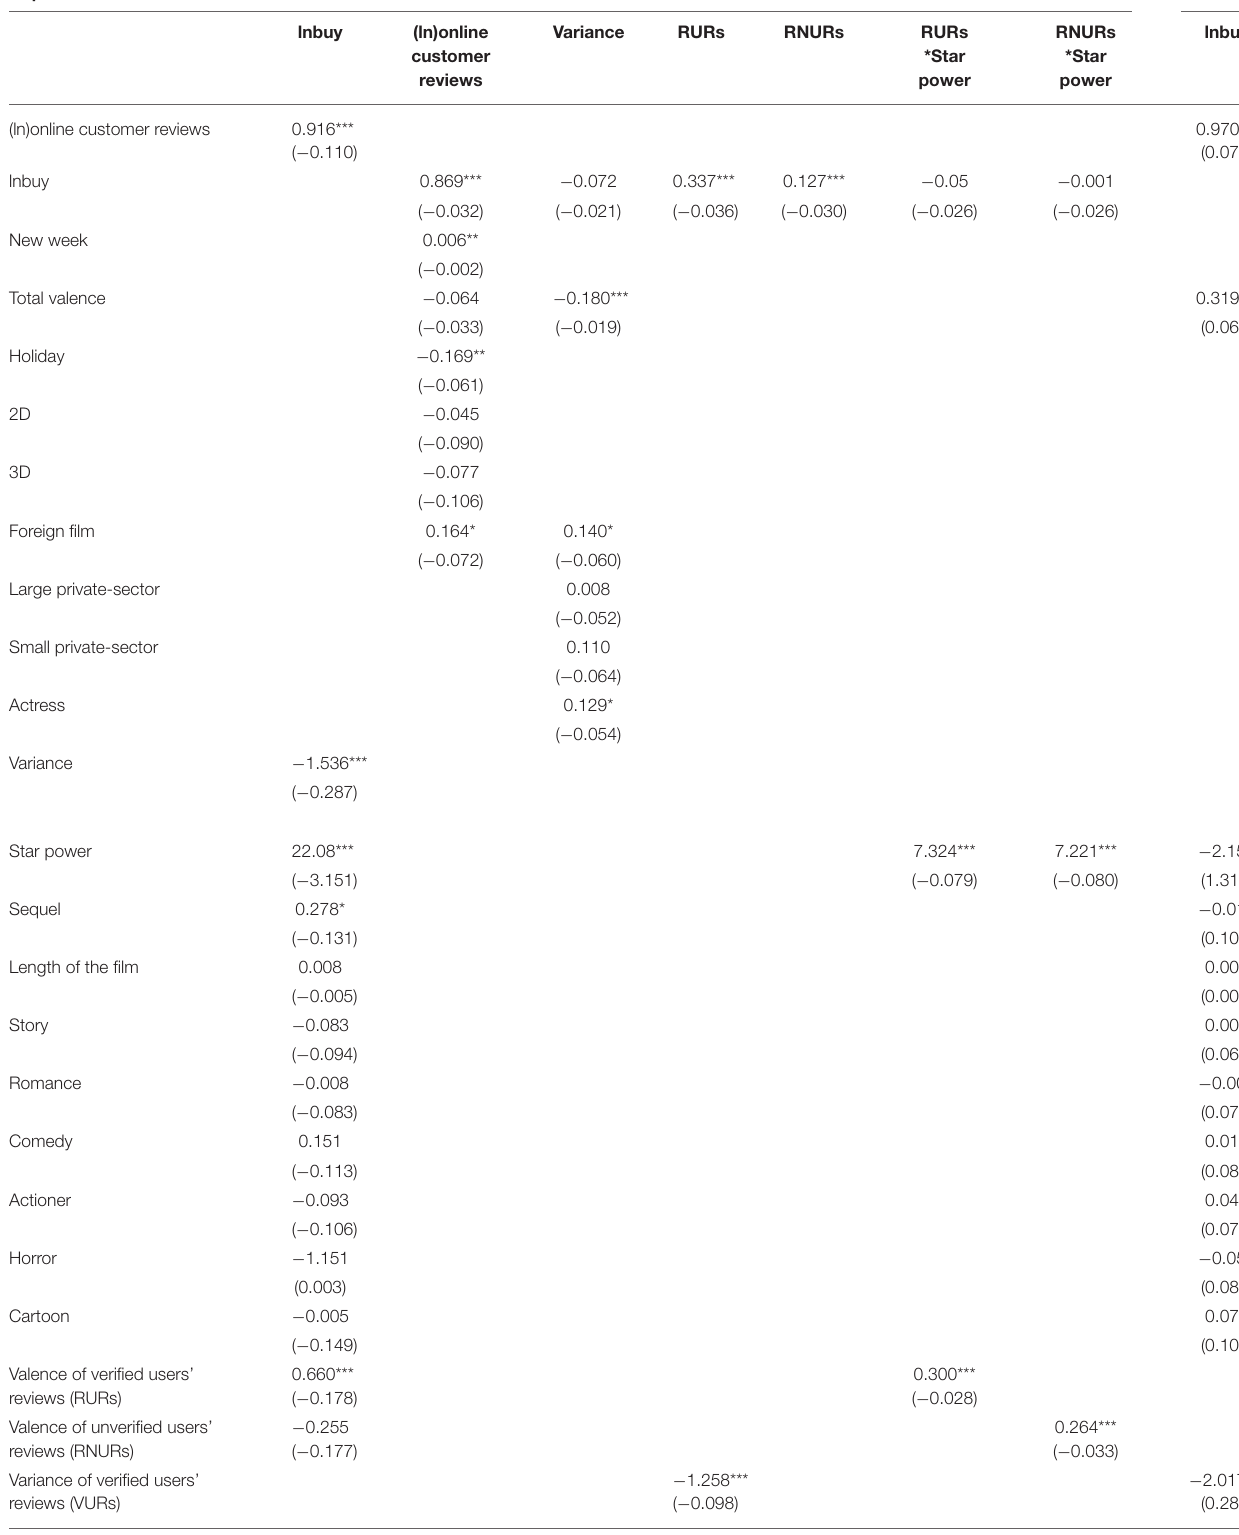
TABLE 3 | Endogeneity control (simultaneous equations). Dependent variable: the total number of online ticket sales Model